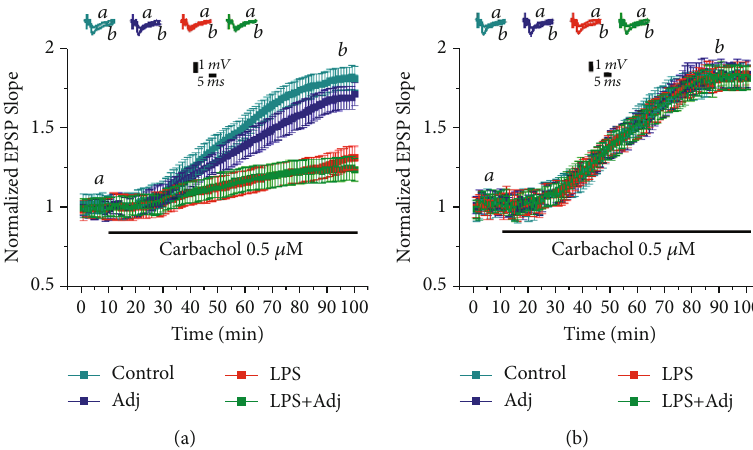
Figure 1: LPS transiently a ff ects mLTP after a short treatment. (a) mLTP is impaired in animals treated with LPS and LPS+Adj for a week. (b) Upon interruption of the treatment for a week, mLTP is restored in LPS and LPS+Adj animals. Further details of the results and the statistical comparisons are described in “ Results. ” In each panel of data, the top traces are sample illustrations of original records before (a) and after (b) the application of 0.5 μ M